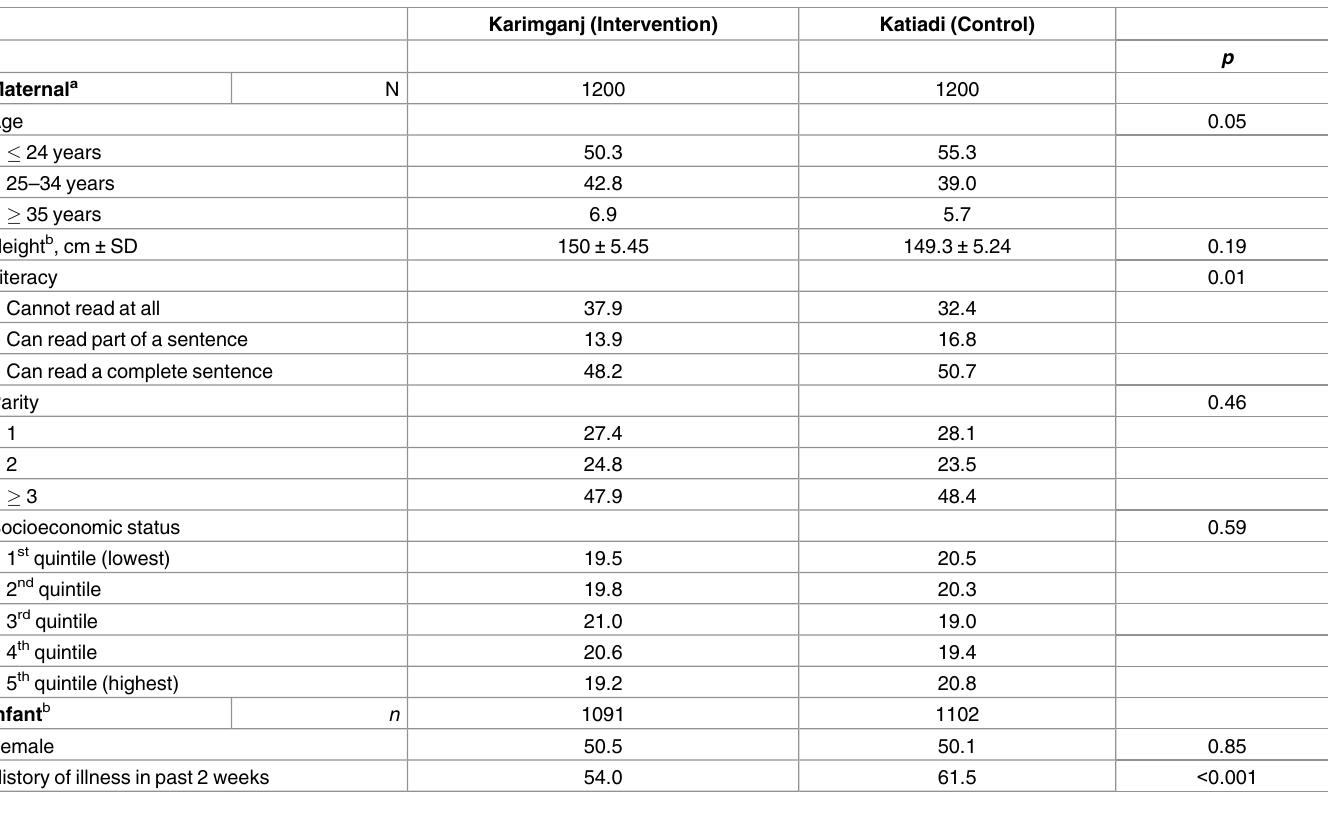
Table 1. Selected characteristics of mother-child dyads in Kishoreganj, Bangladesh. Karimganj